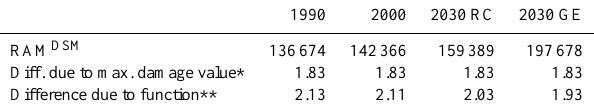
Table 2. Potential flood damage along the Rhine (Million C) for different time-steps, according to the Rhine Atlas and the Damage Scanner damage model.